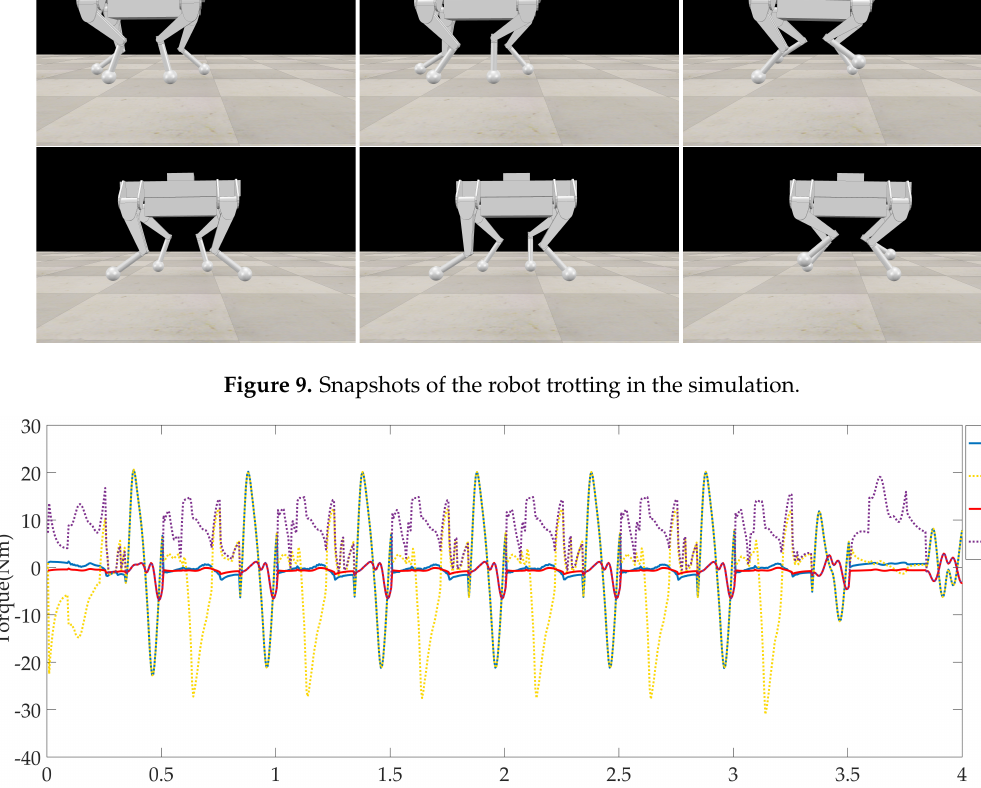
Figure 10. Joint torques of the quadruped robot during a forward velocity of ~0.4m/s. τ m is the torque at the joint, τ * is the torque to move the robot that are in contact with the ground. The torques stay well below the physical torque limit of 30 Nm.